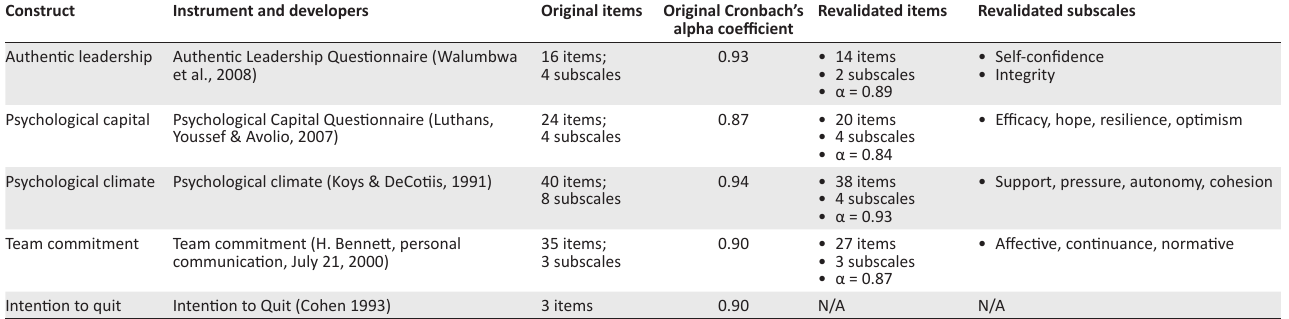
TABLE 1: Summary of measuring instruments’